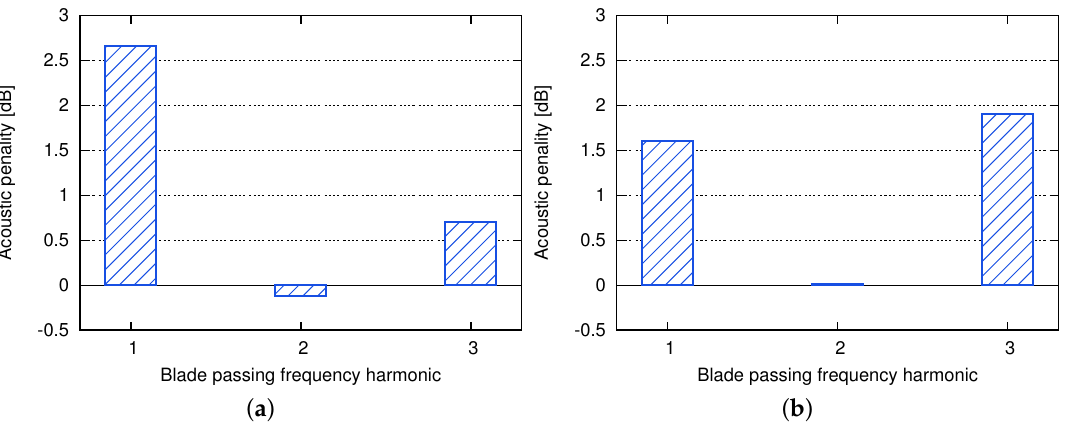
Figure 19. Total acoustic penalty induced by the air-inlet distortion. ( a ) Upstream; ( b )